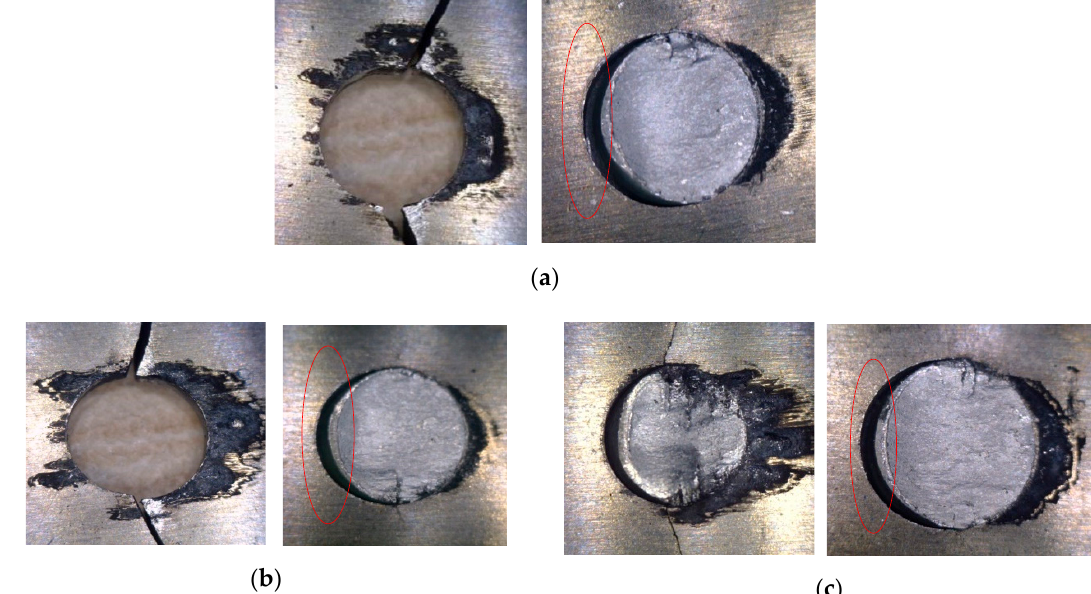
Figure 22. High-cycle fatigue failure and low-cycle fatigue failure of riveted joints of different riveting angles: ( a ) comparison of high-cycle fatigue and low-cycle fatigue failures of 0° standard part (0-0); ( b ) comparison of high-cycle fatigue and low-cycle fatigue failures of riveted parts of 1° in the 0° direction (0-1); ( c ) comparison of high-cycle fatigue and low-cycle fatigue failures of riveted parts of 2° in the 0° direction (0-2).